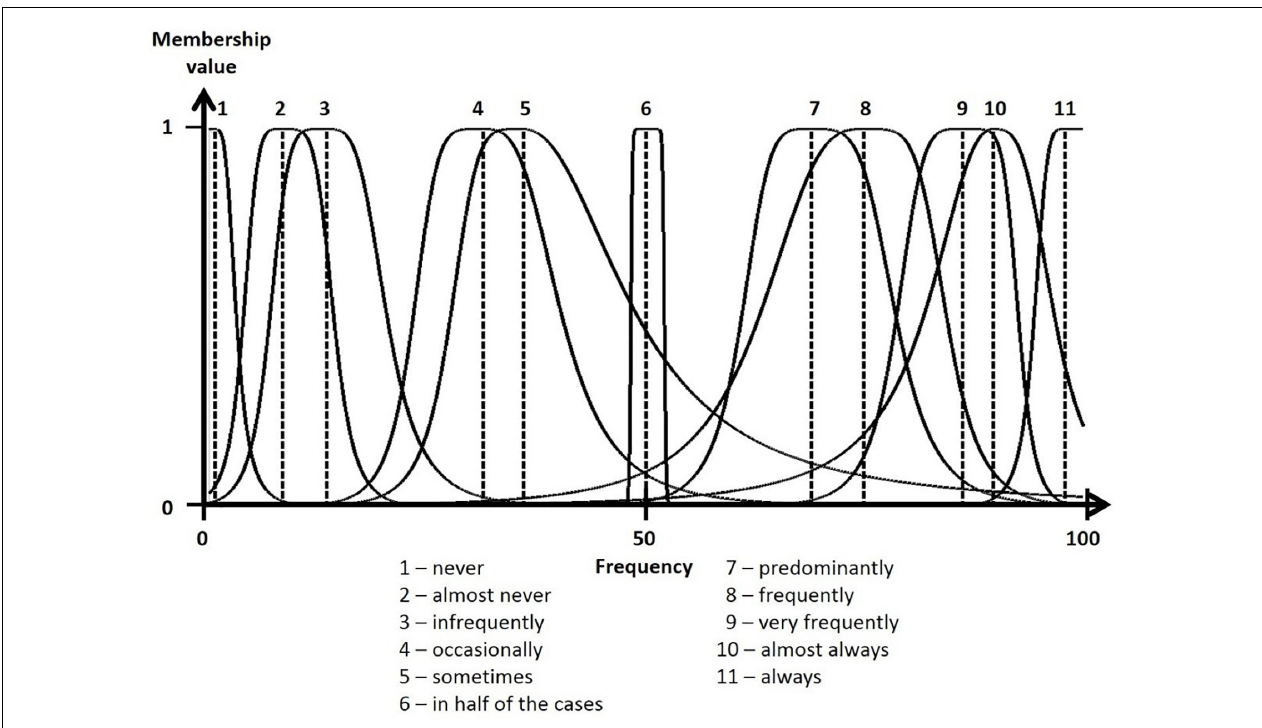
FIGURE 1 | Membership functions of the 11 verbal frequency expressions.